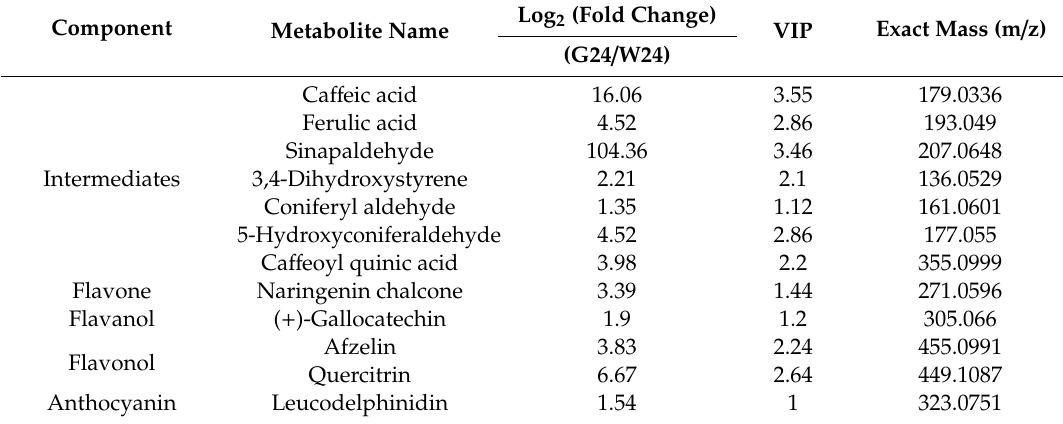
Figure 2. Kyoto Encyclopedia of Genes and Genomes (KEGG) pathway annotation of all the different metabolites. Table 1. Upregulated phenylpropanoids in G24 compared to W24.